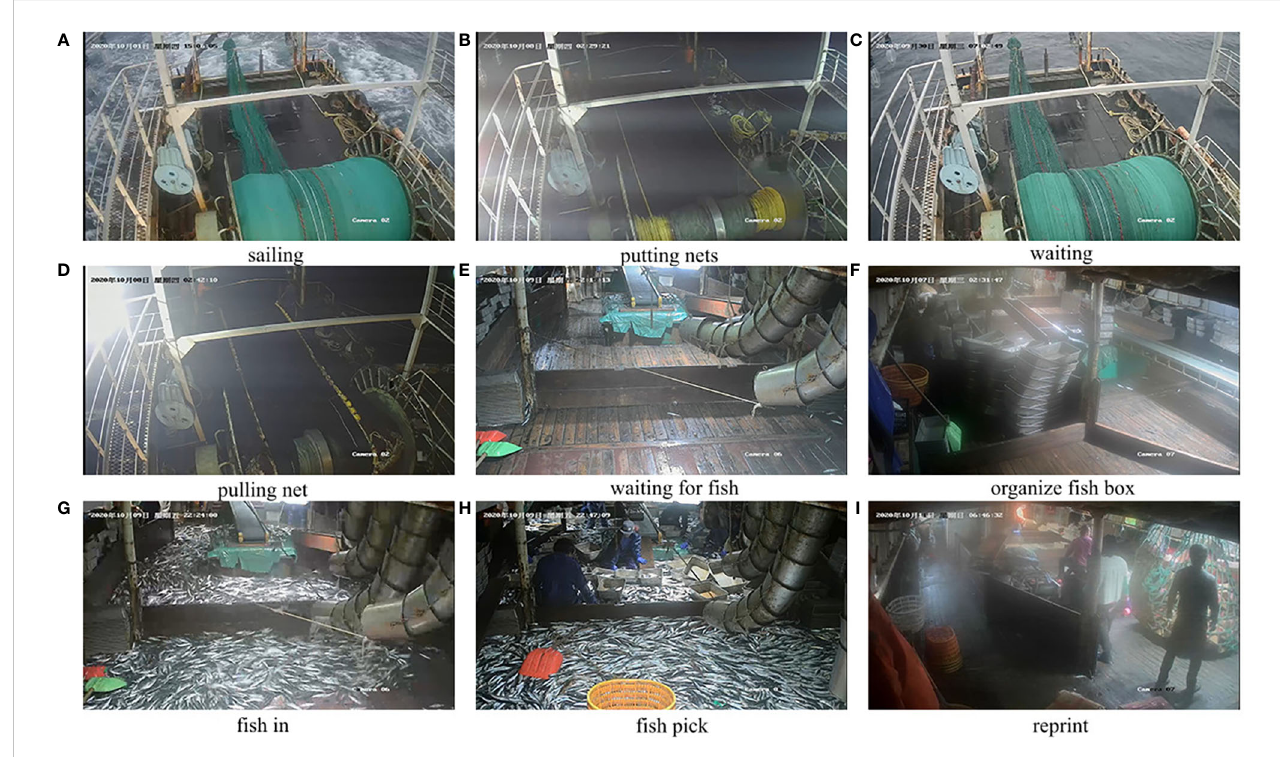
FIGURE 2 Nine kinds of ship behavior re fl ected in EMS.